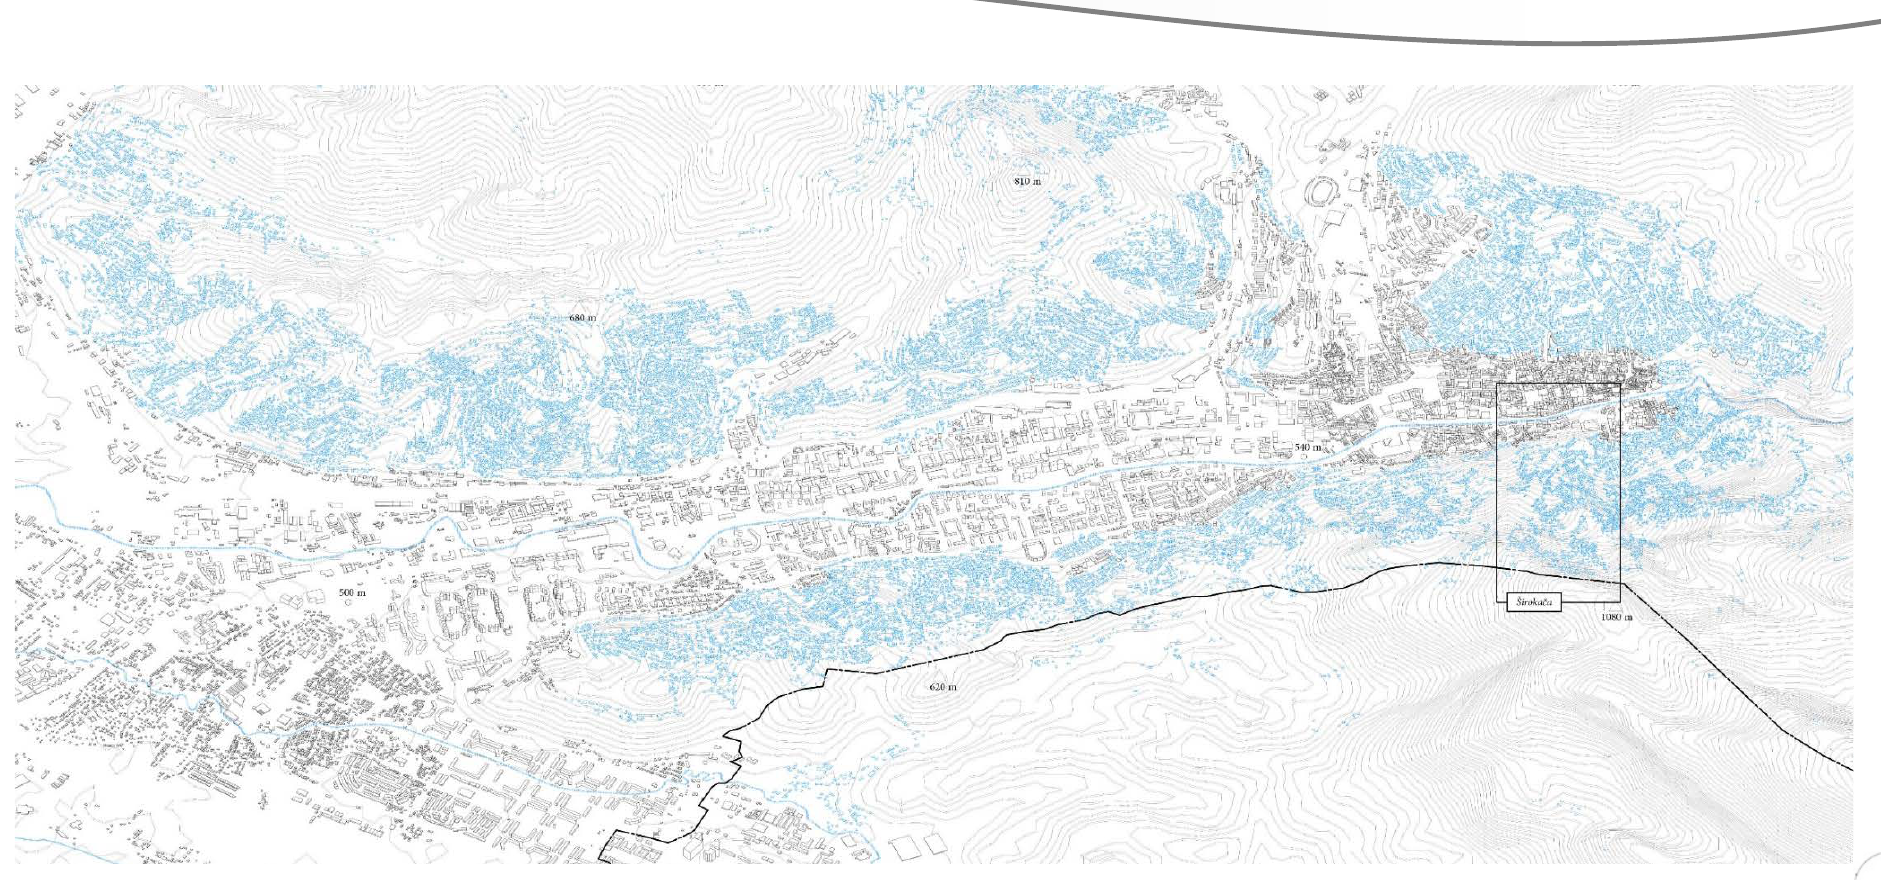
Figure 8: The mahalas of Sarajevo (in blue), the case study of Širokača (rectangle) and the IEBL (black dotted line) in an axonometric view from the